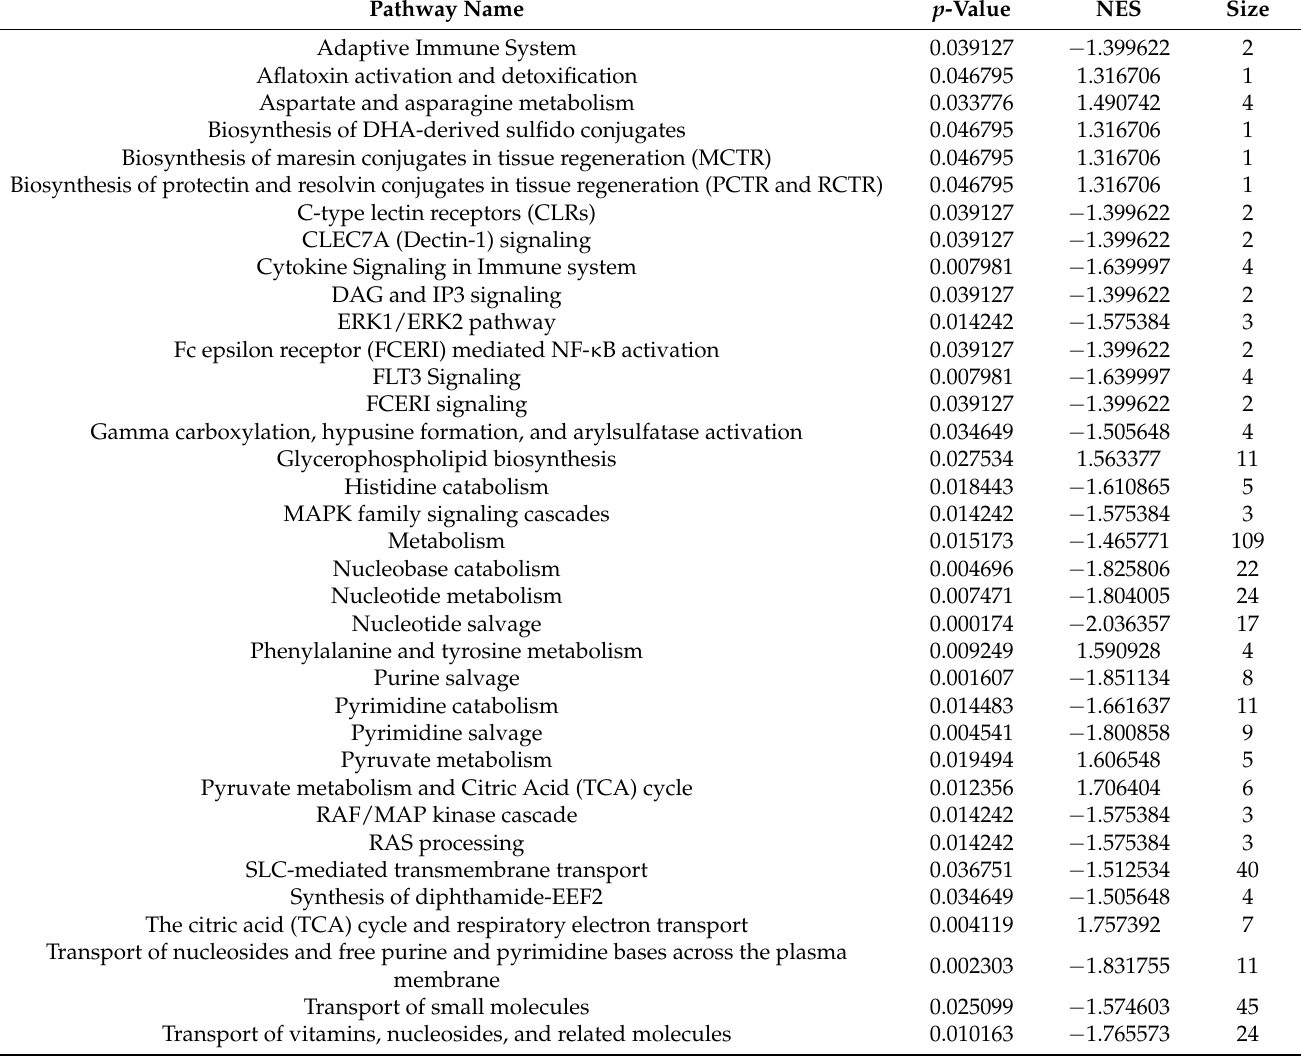
Table 2. Metabolite set enrichment analysis based on the Reactome